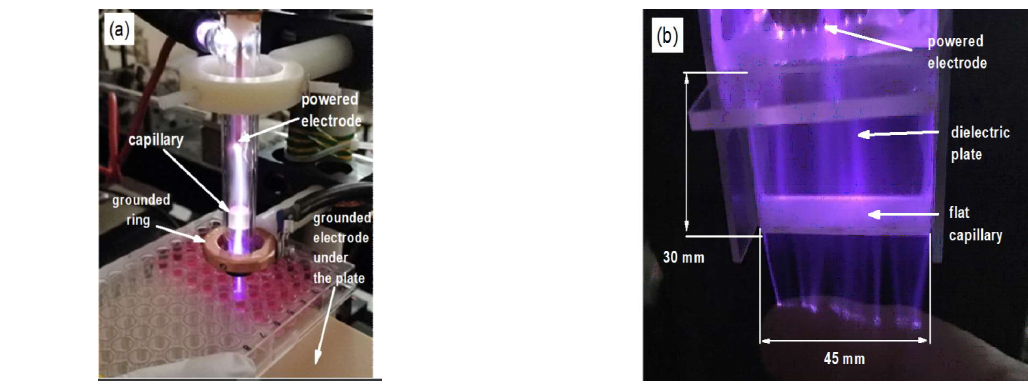
Figure 1. Plasma devices with the cylindrical ( a ) and planar ( b ) designs. The plasma jets are generated in helium.